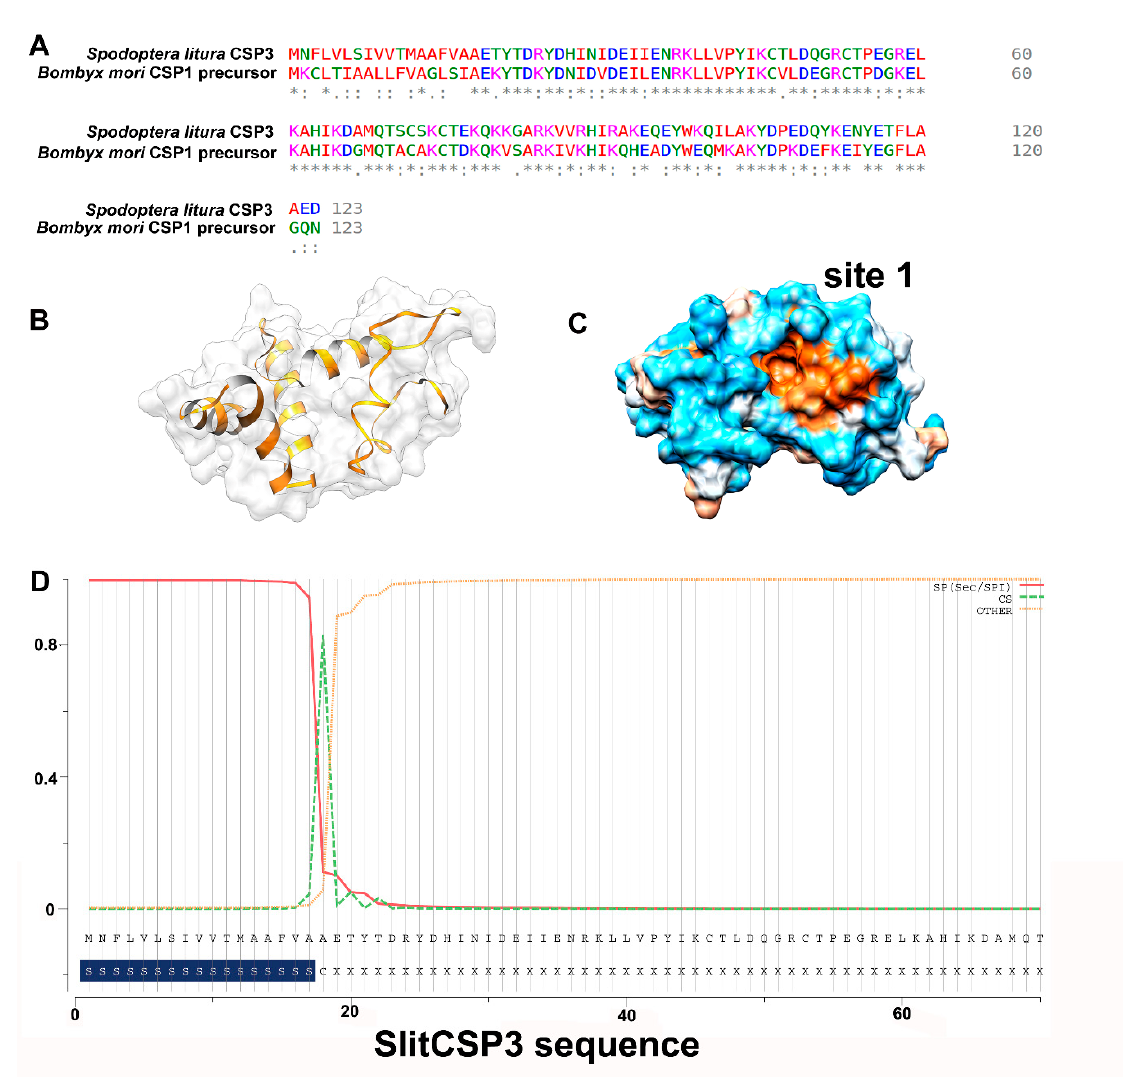
Figure 1. ( A ) Sequence alignment to see the conservation between SlitCSP3 and B. mori CSP1 precursor sequence. The sequences are well-conserved except at the N-terminus, which was not included during structure modeling. ( B ) Three-dimensional model predicted through homology modeling. ( C ) A representation of its hydrophobic surface with orange depicting the hydrophobic core. ( D ) The prediction of signal peptide sequence present in SlitCSP3 at the N-terminus till 17th residue, and 18th is the cleavage site.